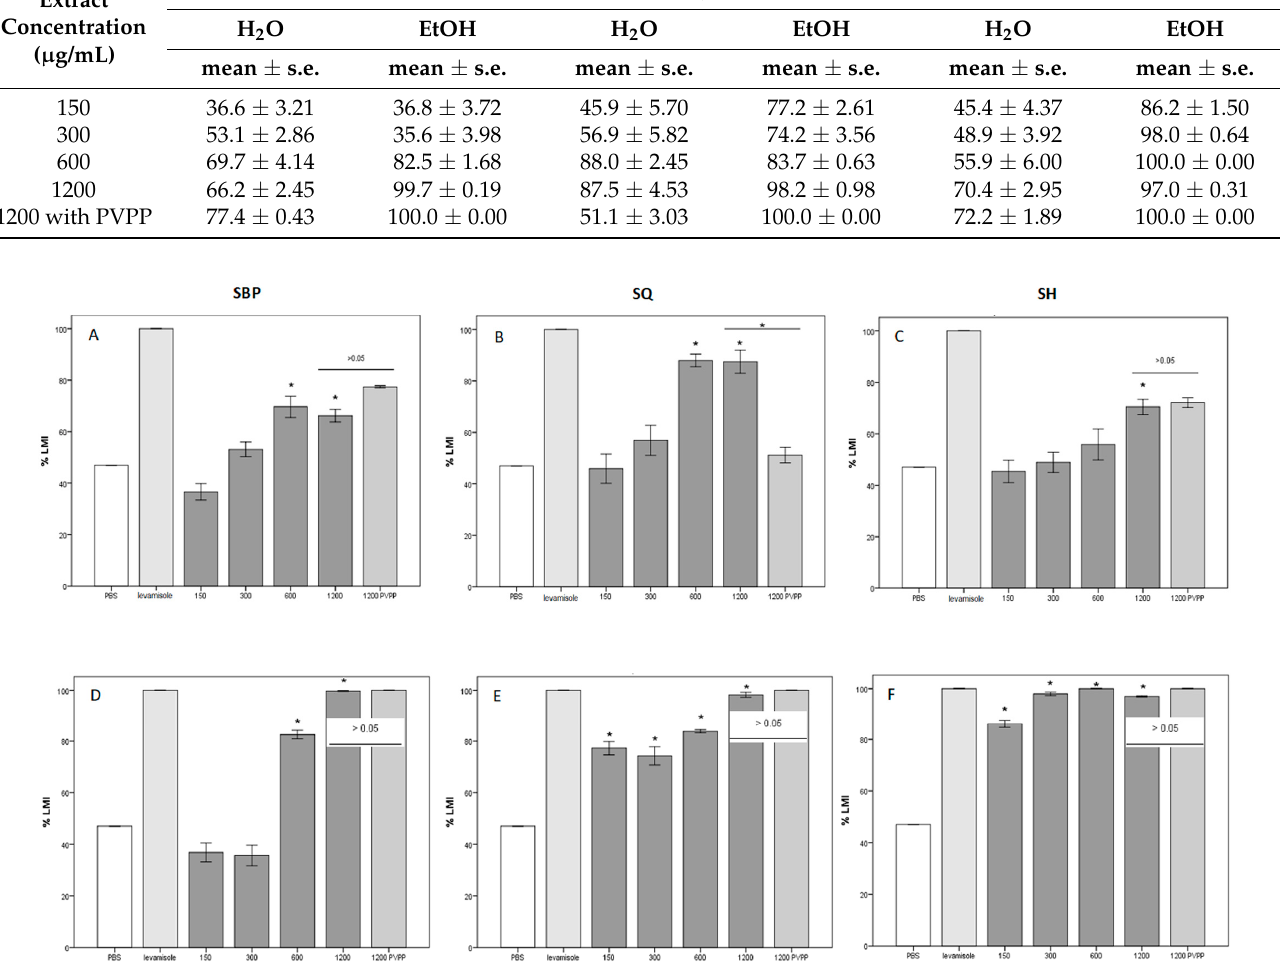
Figure 4. Percentage of inhibition of larval migration with various concentrations of the tested extracts (%LMI). Compared to phosphate buffer saline (PBS), levamisole, or polyvinylpolypyrrolidone (PVPP). %LMI of PBS (negative control): 47%, %LMI of levamisole (positive control): 100%. The significant inhibitory effects ( p -value < 0.05, one-way analysis of variance, followed by Dunnett’s for PBS and by Tukey’s post hoc test for PVPP) are indicated with *. Each bar represents mean ± standard error of the mean. ( A – C ) = H 2 O (water) extracts; ( D – F ) = EtOH (ethanol)